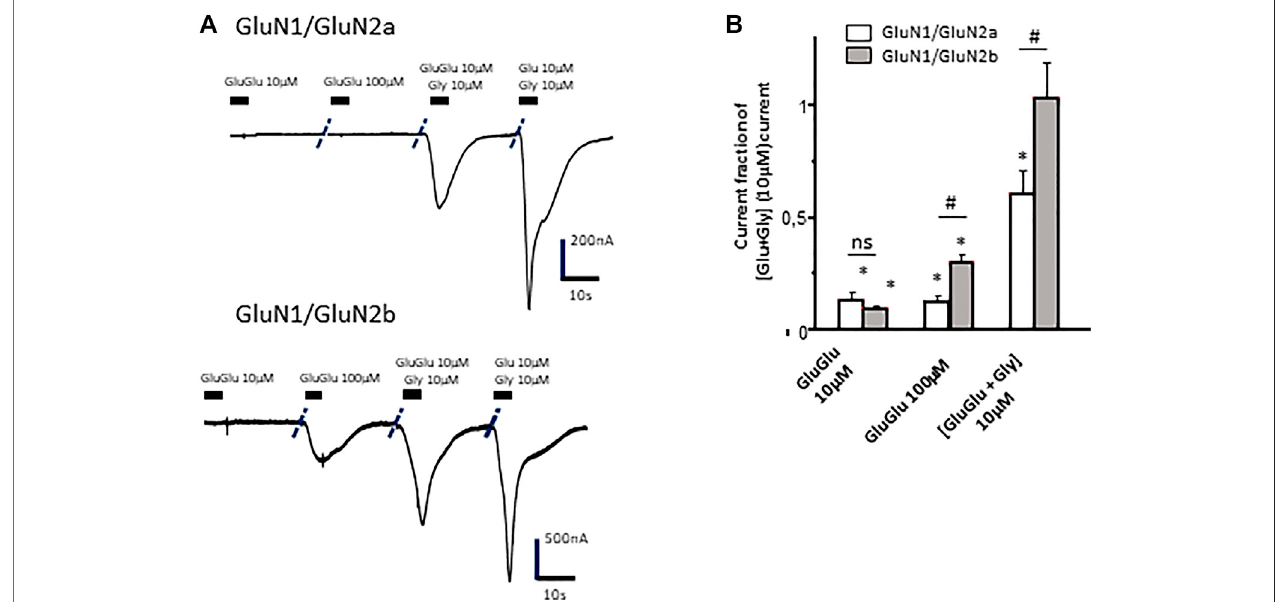
FIGURE 4 | Effect of γ -Glu-Glu on GluN1/GluN2A- and GluN1/GluN2B NMDAr-expressing Xenopus oocytes. (A) Current traces obtained from GluN1/GluN2A- (top) and GluN1/GluN2B- (bottom) expressing oocytes in the presence of γ -Glu-Glu and Glu alone or in combination with glycine. (B) Recapitulative graph plotting current amplitudes expressed as fractions of the current obtained by co-applying Glu and Gly (each at 10 µM) in both GluN1/GluN2A- and GluN1/GluN2B-expressing oocytes.Dataarepresentedasaverages( ± SEM)of12independentexperiments.*indicatesasigni fi cantdifferencebetweenagivenconditionandtheglutamate+ glycine effect. # indicates a signi fi cant difference between the current amplitudes recorded on GluN2A-expressing oocytes and those recorded on GluN2B-expressing oocytes (two-way